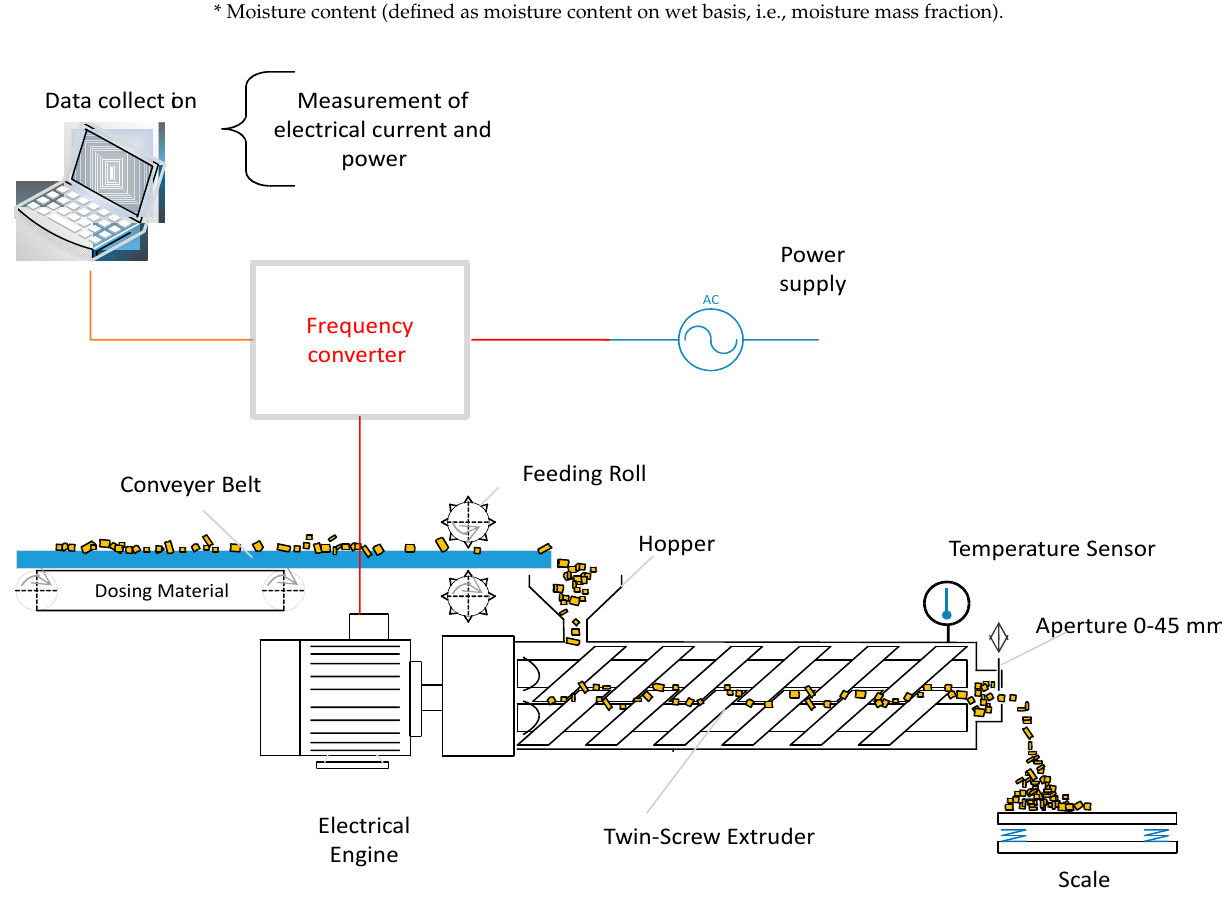
Table 2. Parameters investigated.